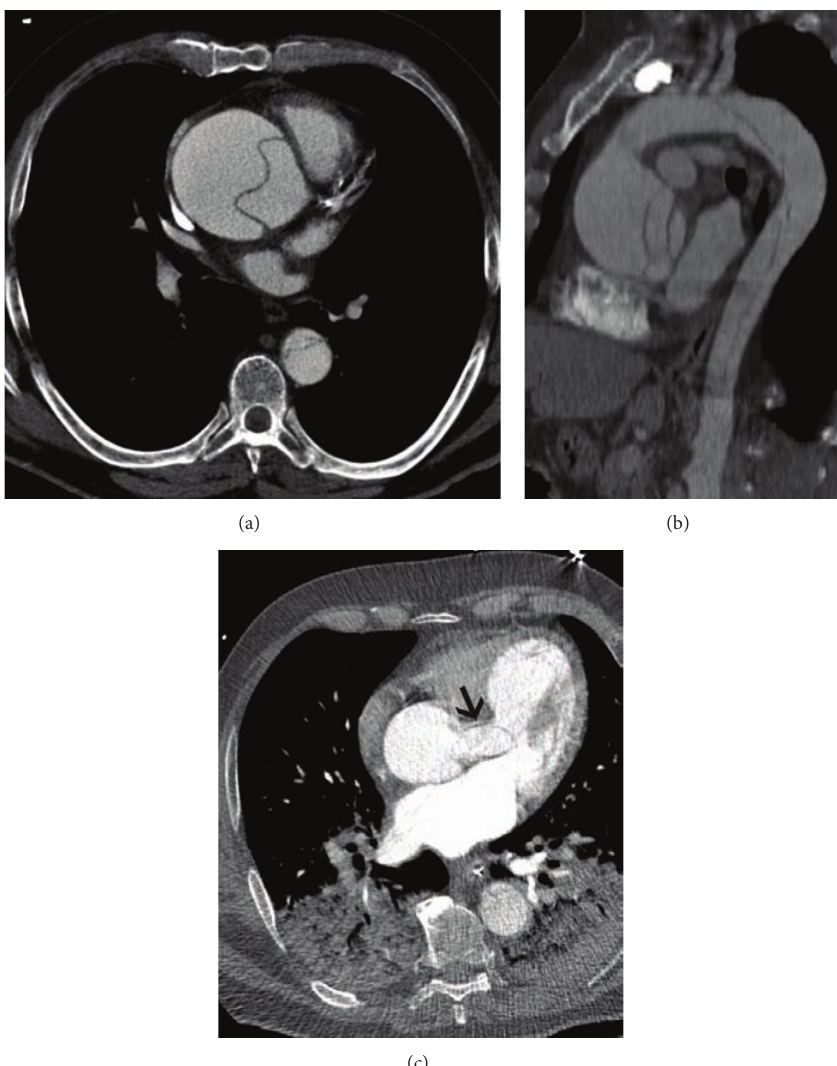
Figure 12: Type A dissection—(a) axial postcontrast CT scan in a 56-year-old male shows a dissection flap that involves the ascending aorta and descending thoracic aorta. (b) Sagittal reconstructed post contrast CT image shows the complete dissection flap, beginning from the aortic root and extending across the arch into the descending thoracic aorta. (c) Axial CT scan in another patient shows a Type A dissection flap in the aortic root that is extending into the left coronary artery, which is